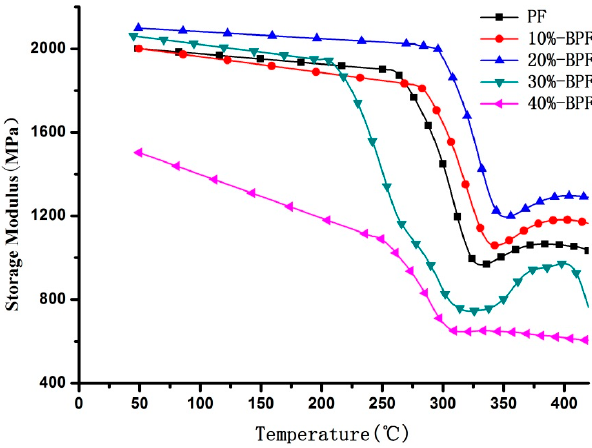
Figure 3. Storage modulus curves of various BPF resins.